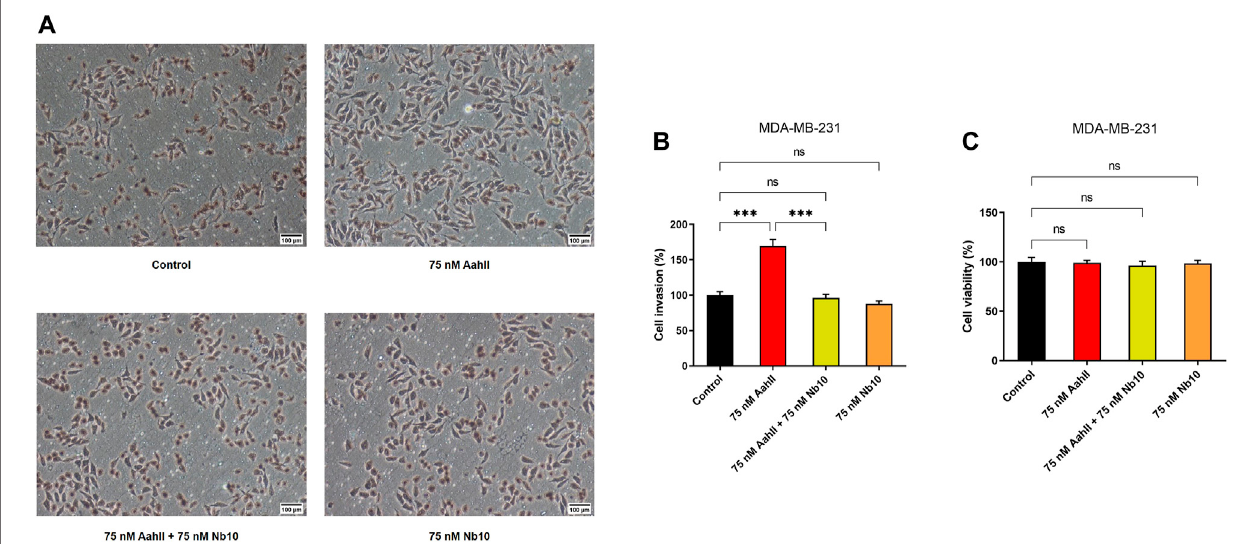
FIGURE 3 | Nb10 can reverse the effect of AahII on MDA-MB-231 cell invasion. (A) Microscopic pictures of fi elds at different conditions. (B) Cell invasion was measured after 24 h of incubation in the control condition (control) and in the presence of AahII and Nb10 alone or combined at a 1:1 ratio. Results shown are representative of independent experiments, n = 3. All data are presented as mean ± SE ( ***p < 0.001). (C) Cell viability was performed in the same condition as (B) . Results shown are representative of independent experiments, n = 3. All data are presented as mean ± SE ( ns, p > 0.05).